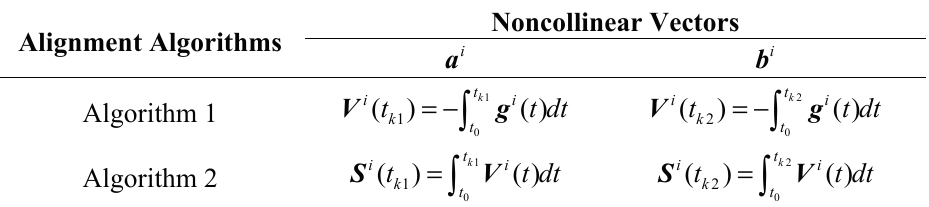
Table 1. Noncollinear vectors in inertial frame i .